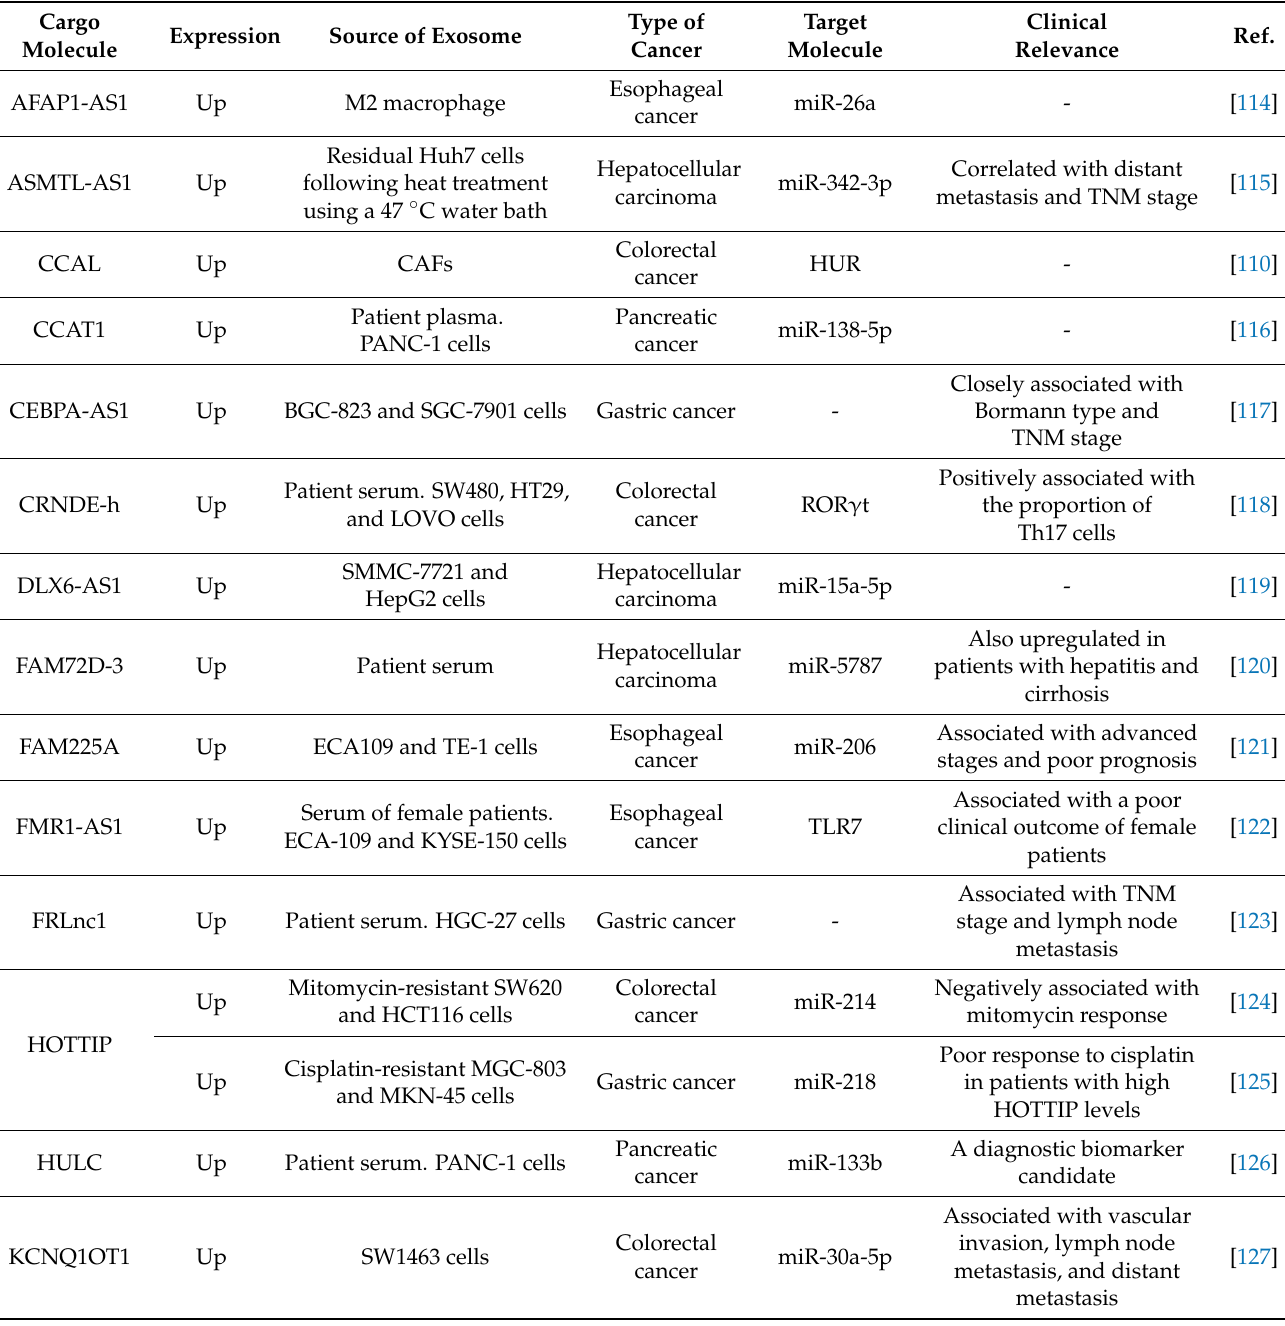
Table 2. Exosomal lncRNAs in gastrointestinal cancers (in alphanumerical